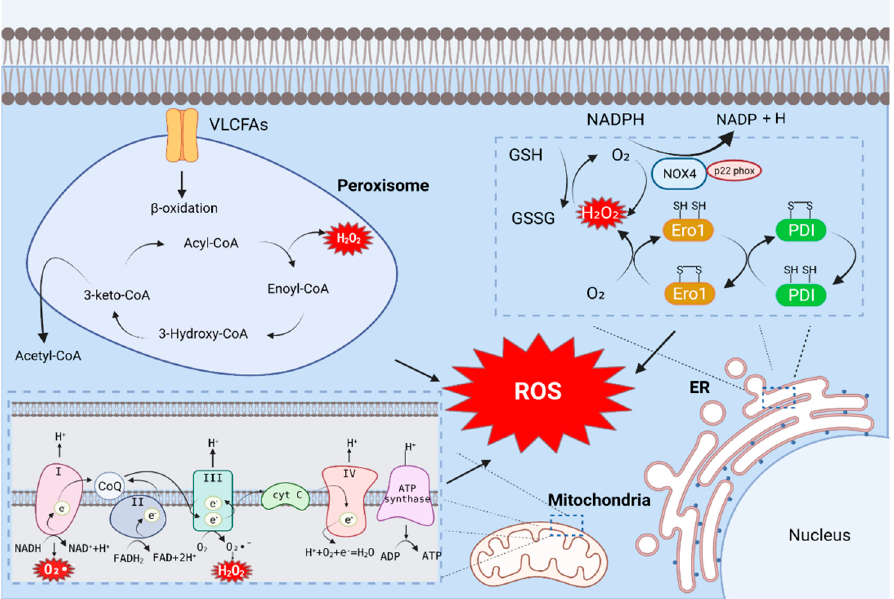
Figure 1. Major source of ROS production in Hepatic cell. The catalytic process of oxidoreductase Ero1 and NADPH oxidase (NOX) in the endoplasmic reticulum generates ROS. During cellular respiration, mitochondria transfer electrons to oxygen and generate ROS as a byproduct of oxidative oxidation. Mitochondrial ROS are mostly produced during oxidative phosphorylation of electron transport chains (ETCs) present in the inner mitochondrial membrane. The main cause of ROS generation in peroxisomes is peroxisomal β -oxidation. Acyl-CoA is converted to Enoyl-CoA by acyl-CoA oxidase containing FAD, which provides electrons directly to oxygen to produce H ₂ O ₂ .